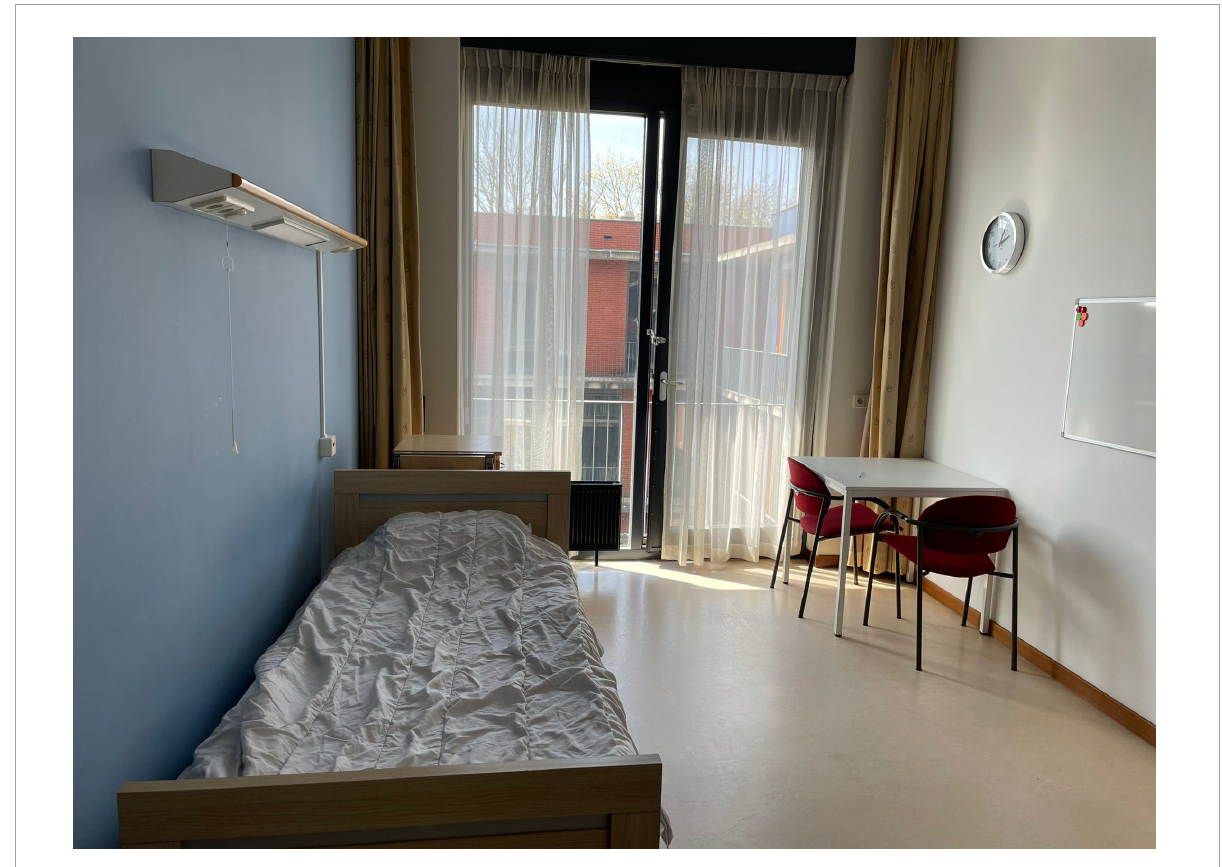
FIGURE2 Typical treatment room at the inpatient clinic (The Hague) also used for esketamine